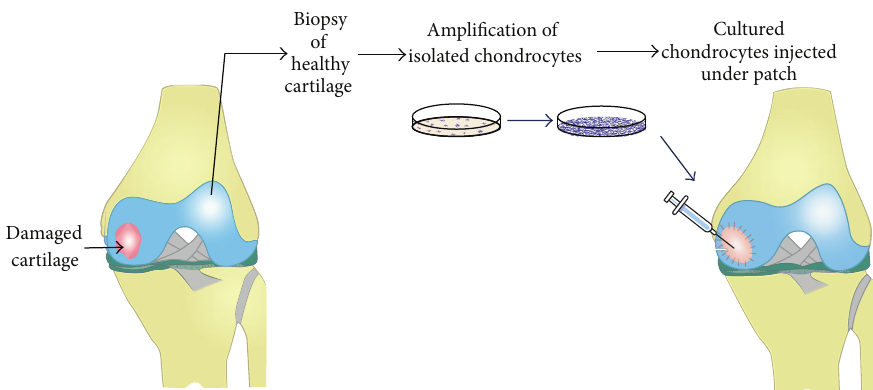
Figure 2: Schematic representation of autologous chondrocyte implantation (ACI) procedures. First, chondrocytes are extracted arthroscopically from the patient’s healthy articular cartilage (nonload-bearing area of either the intercondylar notch or the superior ridge of the femoral condyles). Then, chondrocytes are expanded in vitro for approximately four to six weeks. Finally, once a sufficient number of cells have been obtained, the patient undergoes a second surgery where the cultured and amplified chondrocytes are applied to the damaged area. These transplanted cells grow in their new environment, forming new articular